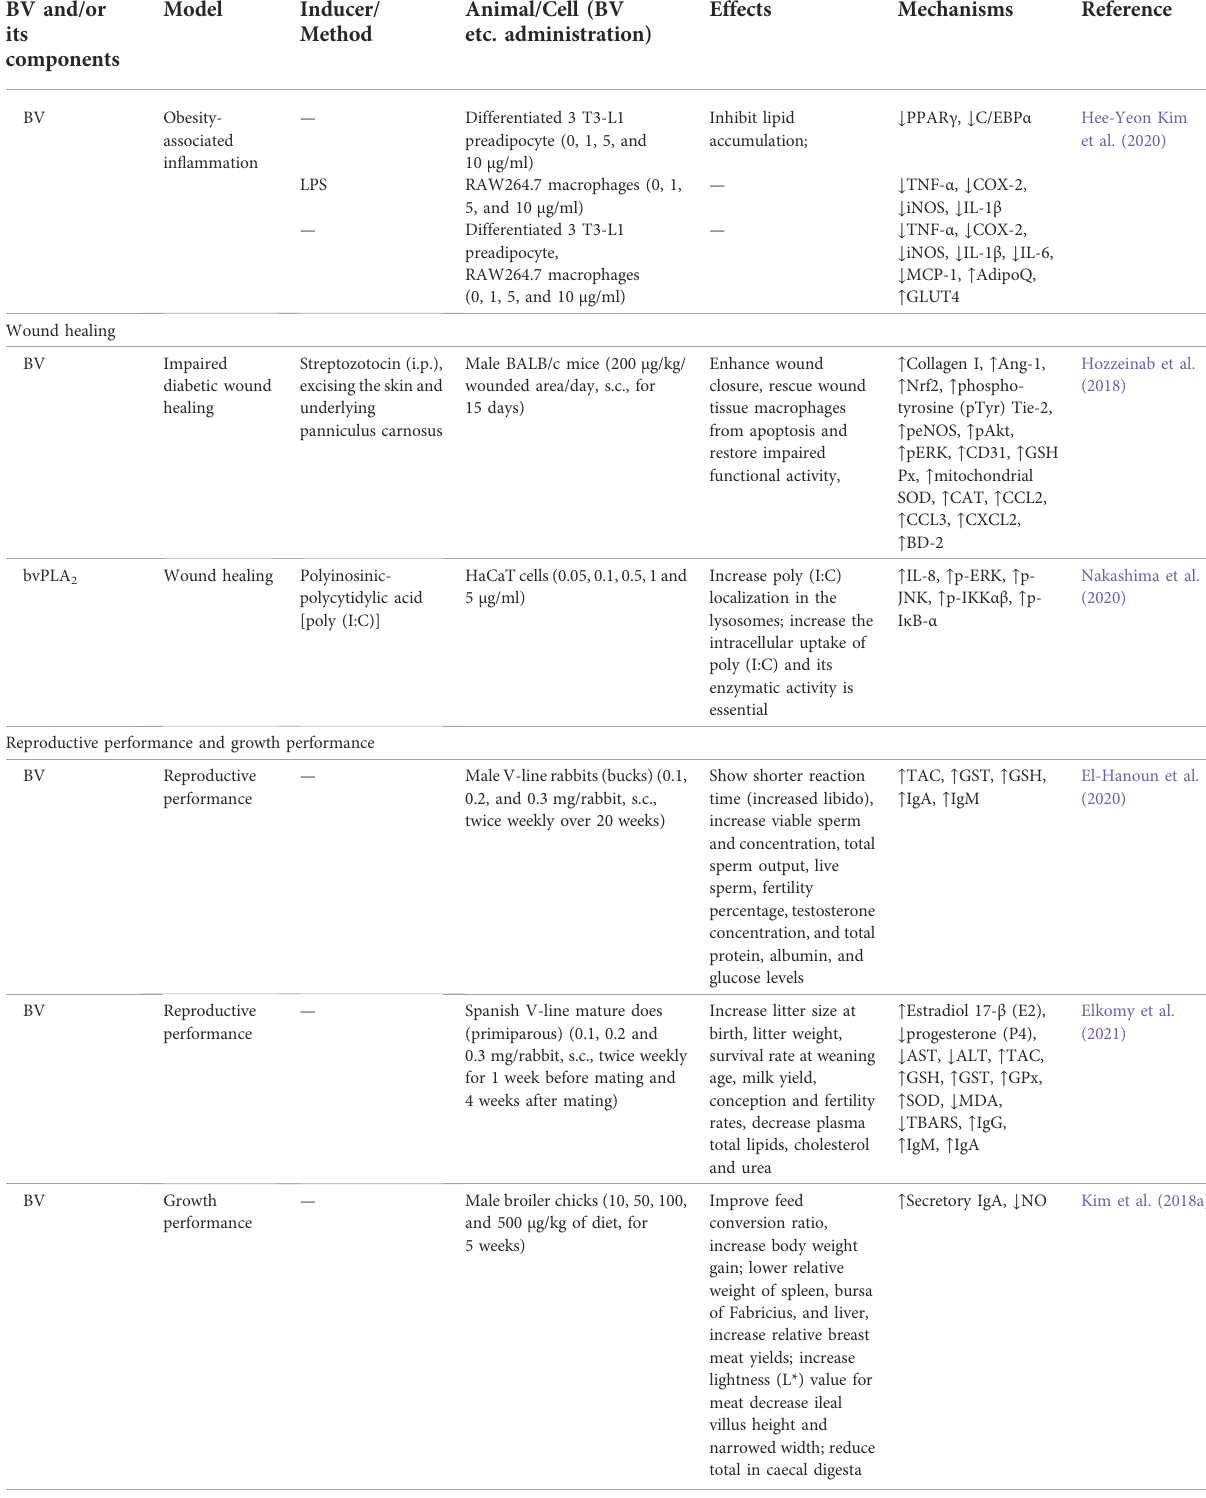
TABLE 7 ( Continued ) Summary of the protect effects and mechanisms of BV and its main components on other